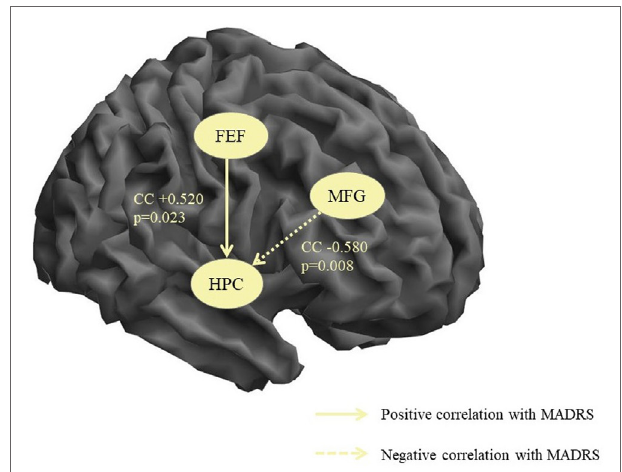
FigUre 2 | Significant correlations between connectivity strengths and depression severity. MFG, middle frontal gyrus, HPC, hippocampus, CC, correlation coefficient, p , significance, MADRS, Montgomery–Åsberg Depression Rating Scale.